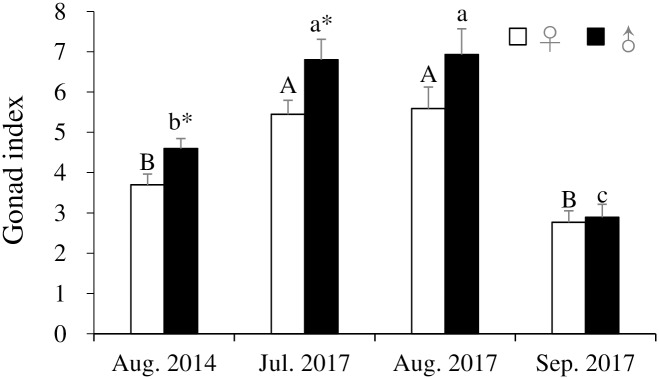
Gonad indices (mean ± SE) of Heliocidaris crassispina by sex in August 2014 and July–September 2017.Asterisks indicate significant sexual differences (p < 0.05). A and B indicate significant differences among months (p < 0.05).